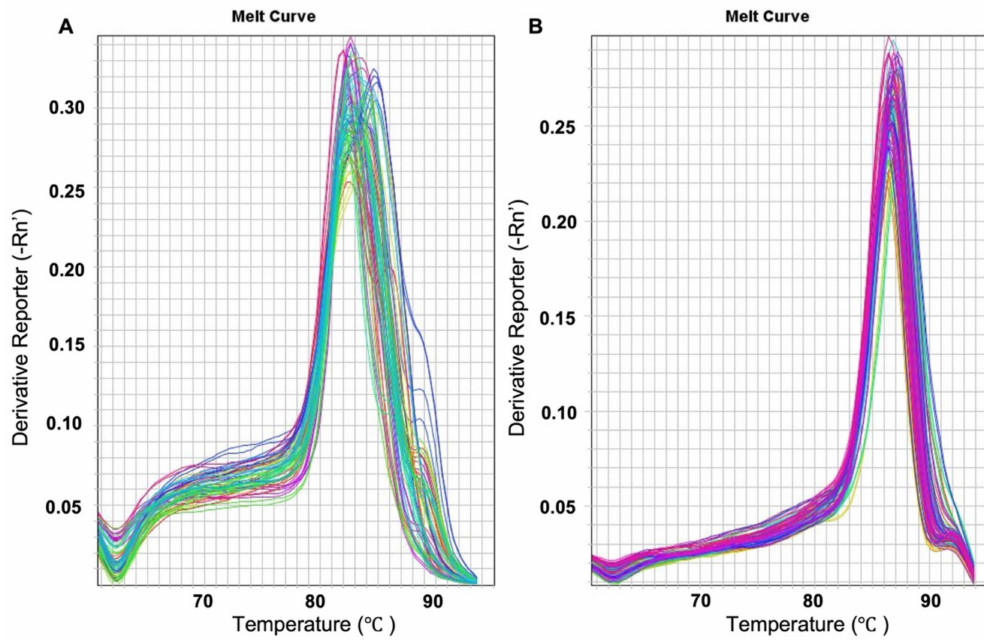
Figure 2. Melt curves from qPCR of 18S rRNA gene ( A ) and 16S rRNA gene ( B